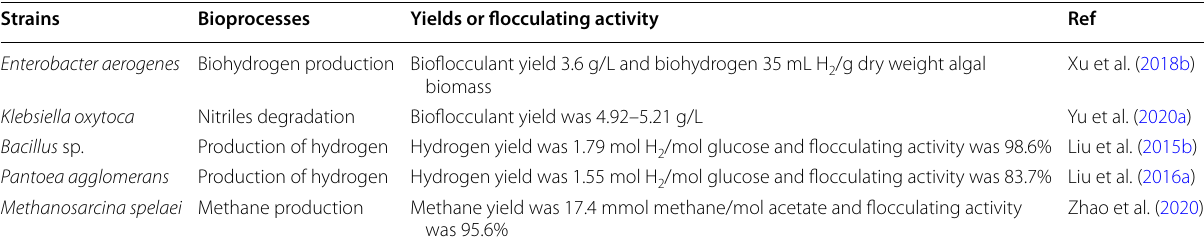
Table 5 Microbial flocculant production as an incidental product of other biological processes